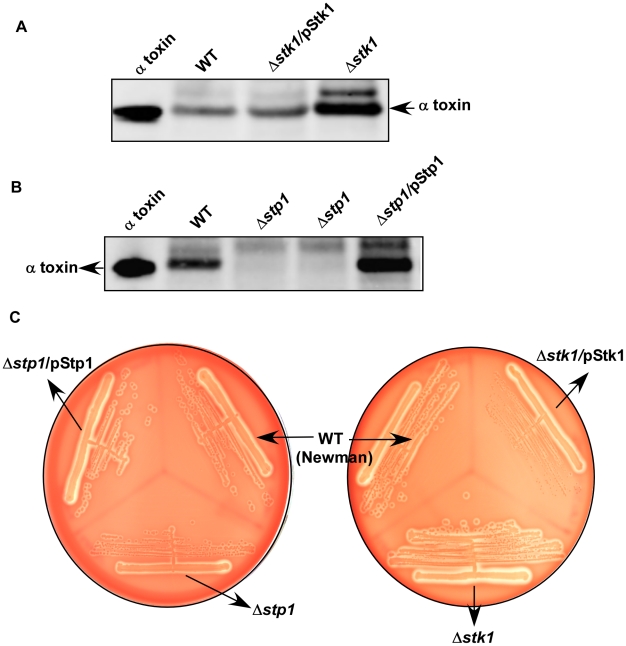
Extracellular α toxin is decreased in a Δstp1 mutant and increased in a Δstk1 mutant compared to WT Newman.(A) and (B) Quantitative western blots for α toxin were performed on equal amounts of extracellular protein from S. aureus WT (Newman), Δstp1, Δstk1 and the complemented strains. As a control, 1µg purified α toxin (Sigma Chemical Co, USA) was included in these assays. Secreted or extracellular α toxin is higher in a Δstk1 mutant and lower in a Δstp1 mutant compared to WT Newman. Two independent Δstp1 cultures were examined in Panel B. Note that α toxin is restored to WT levels in the complemented Δstk1 (Δstk1/pStk1) and Δstp1 strains (Δstp1/pStp1), respectively. (C) shows hemolytic activity of complemented Δstp1 and Δstk1 strains. Note that decreased hemolytic activity in a Δstp1 mutant is restored to WT levels in the complemented Δstp1/pStp1 strain. Likewise, increased hemolytic activity in a Δstk1 mutant is restored to WT levels in the complemented Δstp/pStk1 strain.